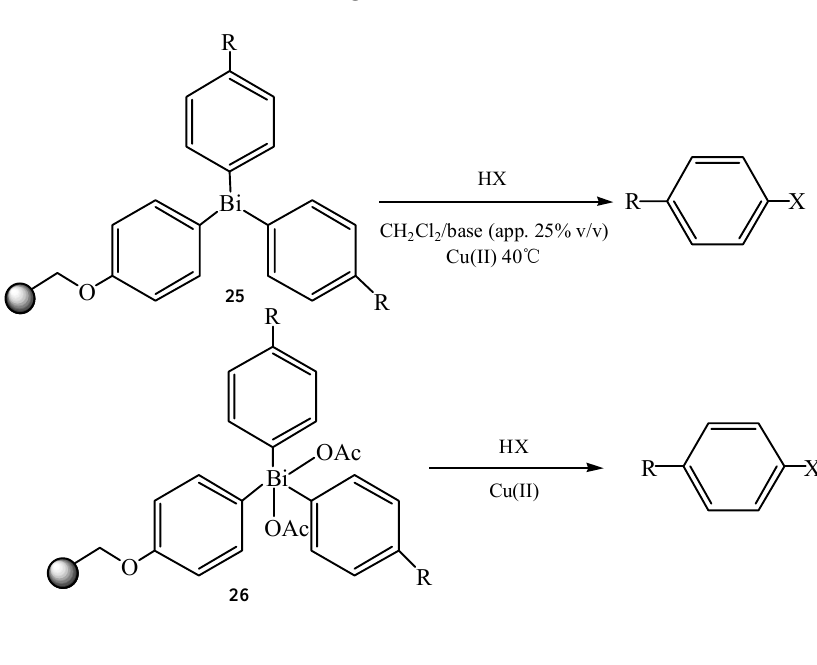
Scheme 30. Cleavage from resins 25 and 26